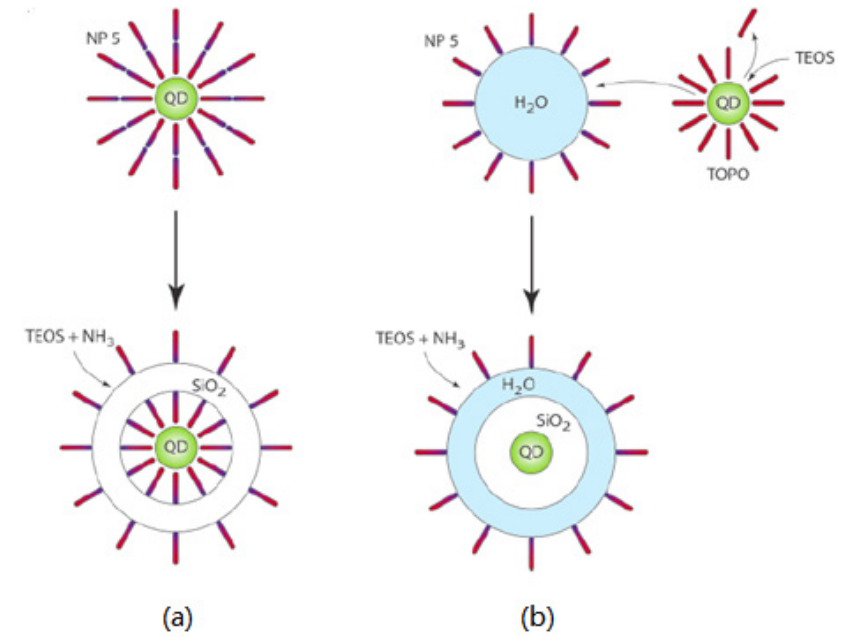
Figure 8. Modular design of silica-coated QDs with functional groups that is readily to crosslink with biological molecules [83] (phosphate, PEG, or ammonium groups on the outer siloxane surface act as stabilizing groups to maintain water solubility).